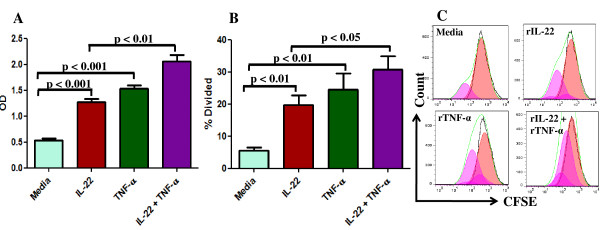
Human rIL-22 induced marked proliferation of FLS in PsA patients. FLS were isolated from synovial tissue of patients with psoriatic arthritis (PsA, n = 5). (A) FLS (20,000 cells/well) of PsA patients were seeded in a 24-well plate in triplicate and incubated for 5 days at 37°C in presence or absence of human rIL-22 (100 ng/ml), human rTNF-α (20 ng/ml) and combination of rIL-22 (100 ng/ml) + rTNF-α (20 ng/ml). FLS used in these experiments were between 3rd and 6th passage. MTT assay was done to determine FLS proliferation and results were expressed as Mean ± SEM of OD. (B) FLS (2 × 105 cells) of PsA patients were seeded in T25 flask in triplicate, stained with CFSE (2 μM) and incubated for 5 days at 37°C in presence or absence of human rIL-22 (100 ng/ml), human rTNF-α (20 ng/ml) and combination of rIL-22 (100 ng/ml) + rTNF-α (20 ng/ml). Data were acquired in FACScalibur flow cytometer and analysis was done using FlowJo software. Proliferation was measured in terms of percent of divided cells and data were expressed as Mean ± SEM. The bar diagram represents the percent divided cells of FLS in PsA patients. (C) A representative histogram showing the proliferative effect of different treatments (rIL-22, rTNF-α, rIL-22 + rTNF-α) compared to media in FLS obtained from PsA patients. Non parametric test, Friedman's ANOVA with Dunn's multiple comparison test was done to determine statistical significance.